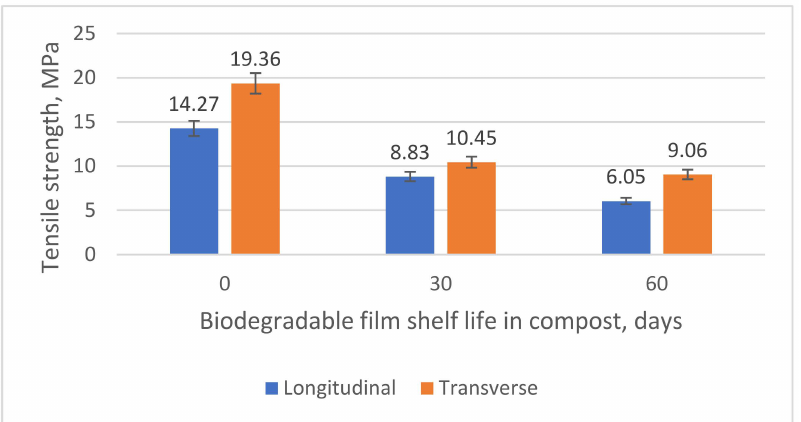
Figure 4. Changes in the tensile strength (MPa) of the biodegradable PLA/PBAT-based film after composting for 60 days.